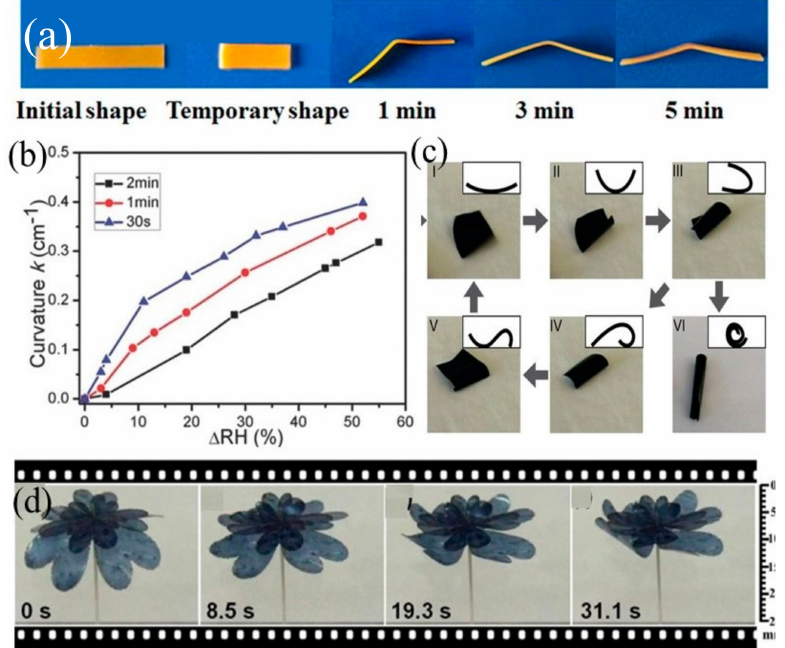
Figure 3. Humidity-responsive of smart materials: ( a ) Water-responsive shape-memory process of the PEG–PCL–CNC nanocomposites in water at 37 ◦ C. Reprinted with permission [49] © 2020 American Chemical Society. ( b ) Dependent curve of bending curvature on the variation of relative humidity ( ∆ RH) for PEG-DA hydrogel films with di ff erent exposure time. Reprinted with permission [52]